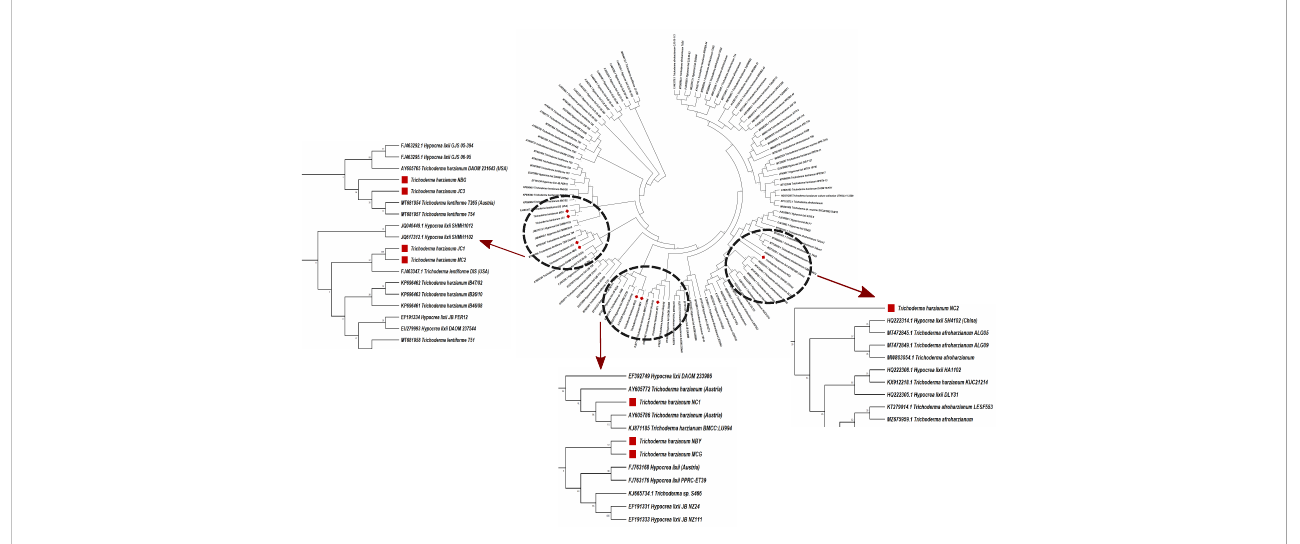
FIGURE 4 Phylogenetic tree of representative isolates of Trichoderma spp. inferred by Maximum Parsimony analysis of Tef-1- a sequences in MEGA 4.0. The bootstrap support from 500 replications is indicated on the branches.